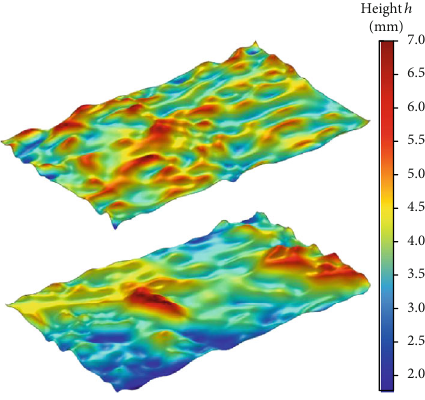
Figure 4: The restored